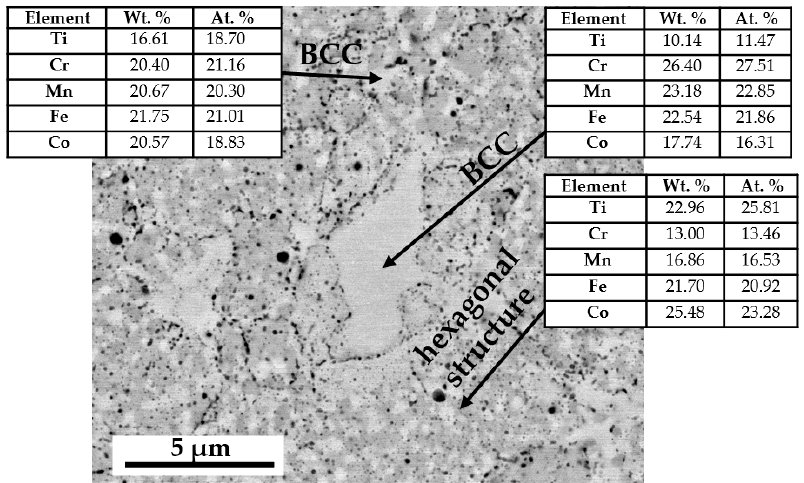
Figure 5. Microanalysis of the TiCoCrFeMn alloy chemical composition after initial sintering in bright areas (BCC lattice-based elements) and grey areas with increased content of elements with a hexagonal lattice. Table 2. The contribution of individual elements (at. %) with the standard deviation for three observed phase areas: large bright area (lb), small bright area (sb) and small grey area (sg) of TiCoCrFeMn sintered and annealed at 1000 °C alloy.